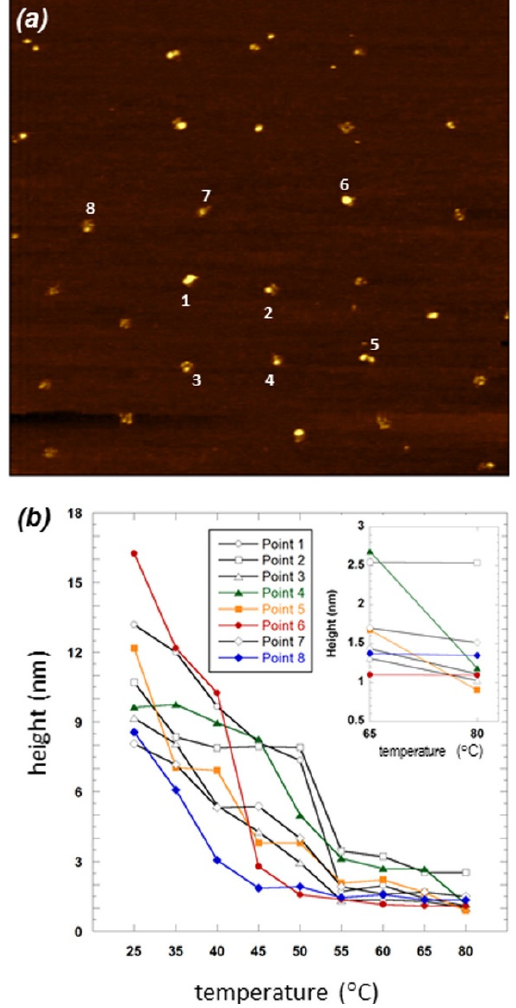
Figure 14. Temperature-dependent changes in height studied in situ with AFM. ( a ) Example topo- graph acquired in water at 25 °C (4 × 4 μ m 2 ) in which the heights of eight polymer brush sites were tracked. ( b ) Measurements of the height changes with increasing temperature at each selected point, with an inset for the interval from 65 to 80 °C (Adapted from ref. [86]. Copyright 2019, American Chemical Society).